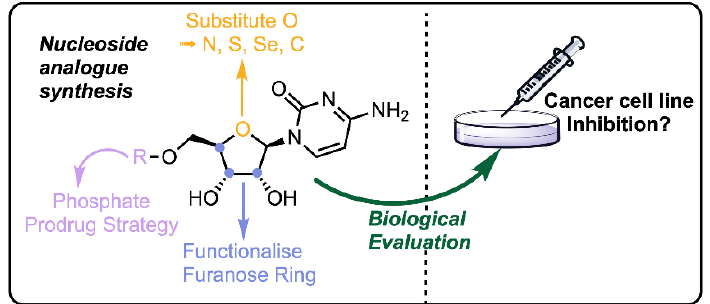
Figure 2. The molecular structures of the reviewed nucleotides [15].